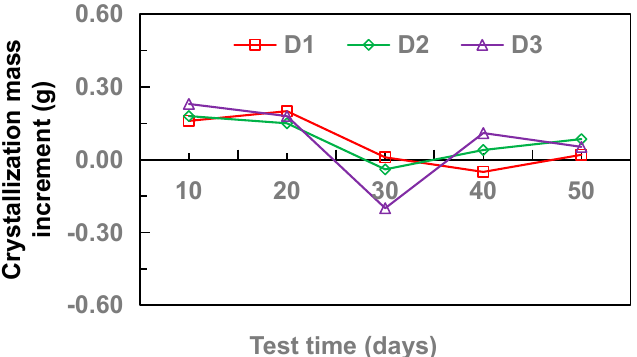
Figure 6. Variation of crystal mass increment with time.